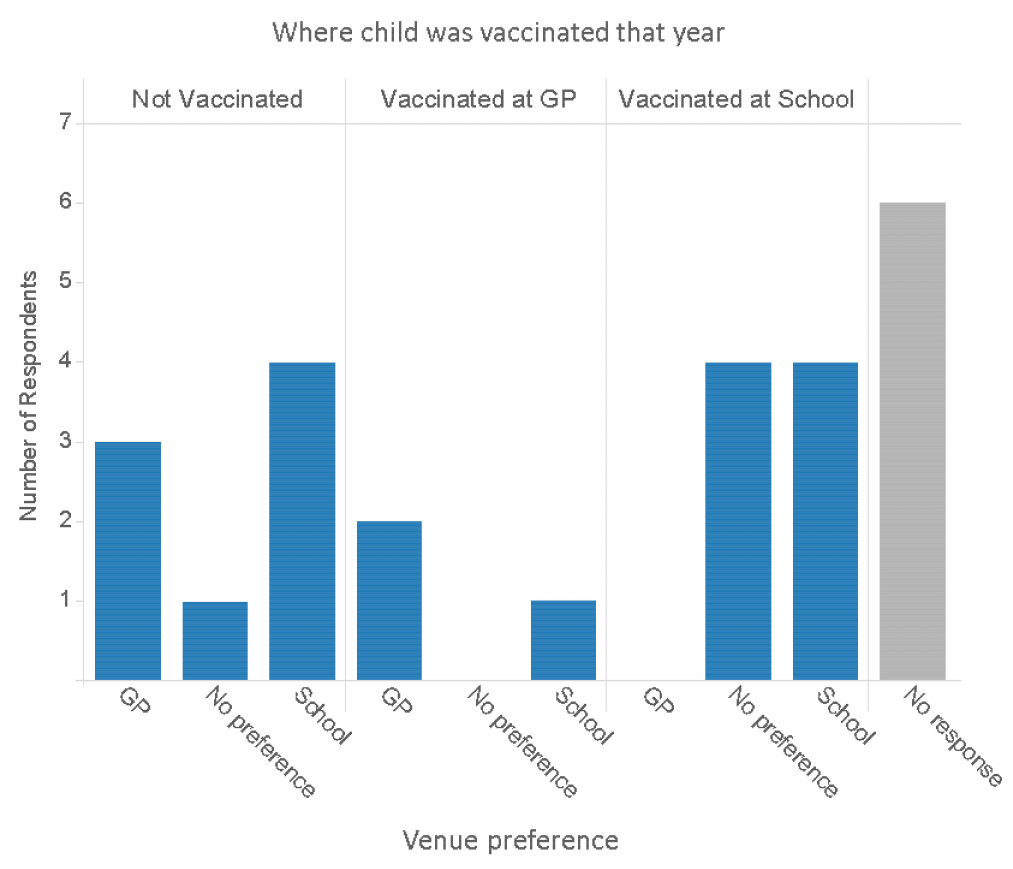
Figure 2. Venue preferences reported on the outreach form, disaggregated by location where child was vaccinated that